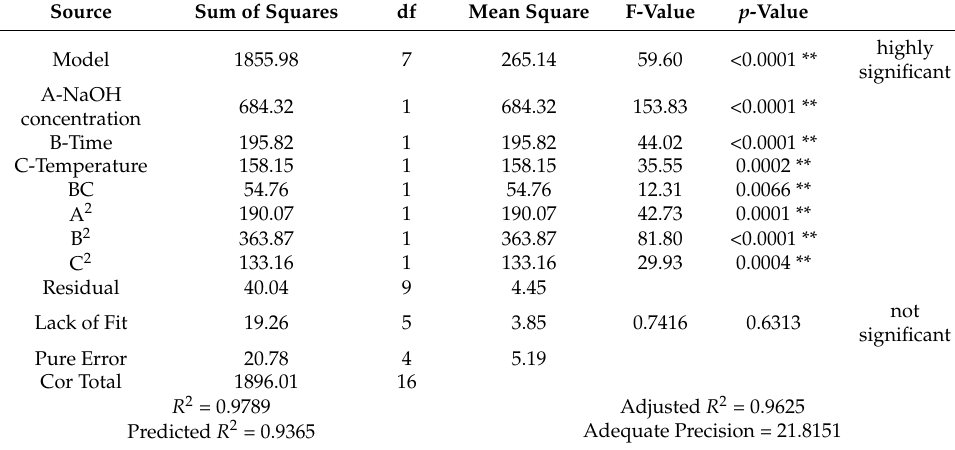
Table 3. ANOVA for coir fiber tensile strength.